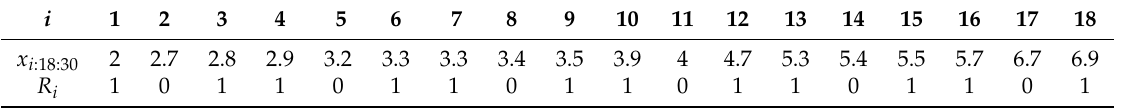
Table 2. Progressive Type-II censored sample generated by Zhang and Gui [10] from the real data.